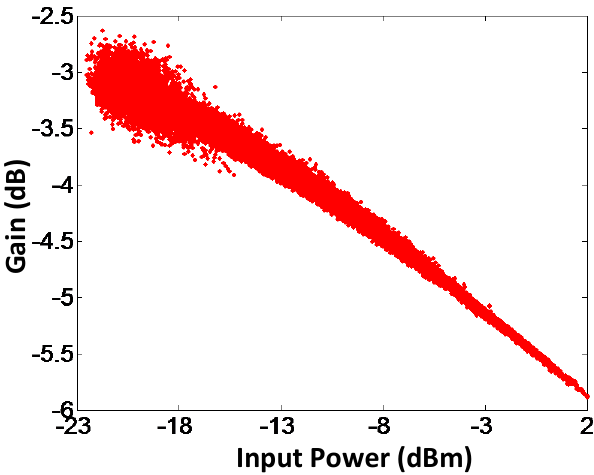
Figure 13. AM-AM characteristics of a single VGA.